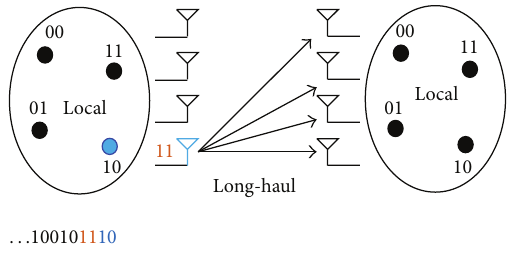
Figure 2: The structure of CMIMO-SM.